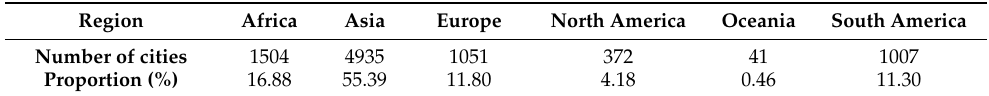
Table 1. Statistics of the 8910 cities across the globe. Region